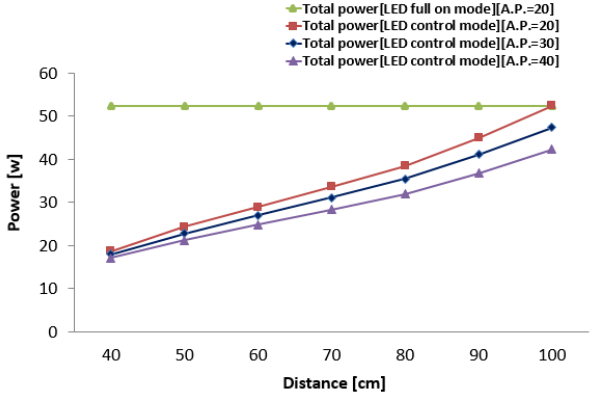
Figure 7. Total power comparison according to various distances and ambient PPFD.